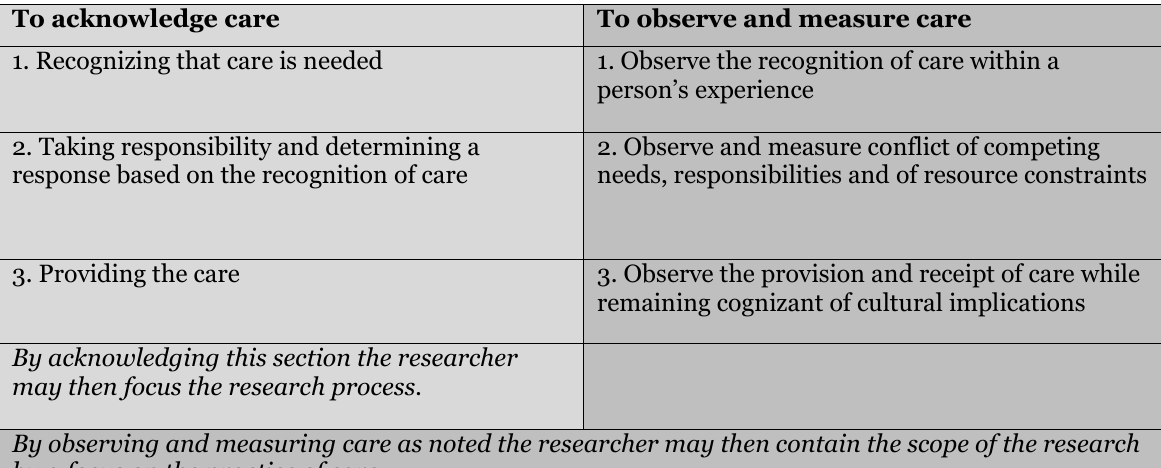
Figure 1. Practice of care framework. From The Ability to Access Post-Secondary Education: Adult Learners’ Conceptions of Choosing Online Learning (p. 20), by K. Rasmussen, 2015, Lancaster University, UK. Copyright 2015 by Kari